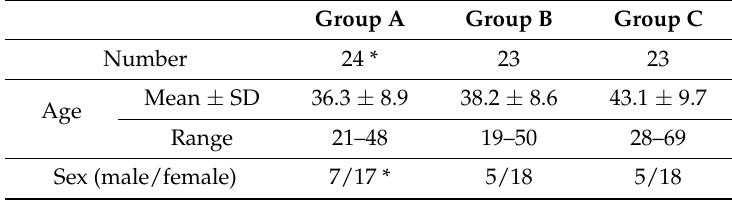
Table 1. Patient demographics. * One patient in Group A dropped out due to de novo pregnancy.